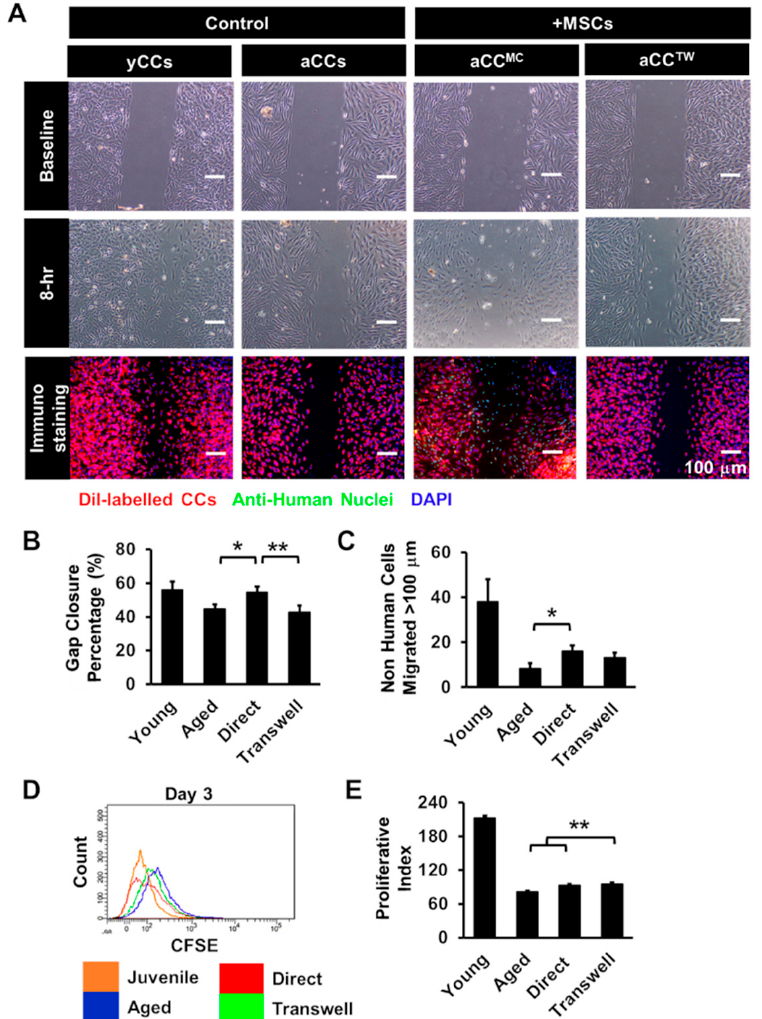
Figure 3. Co-culture with mesenchymal stem cells (MSCs) is capable of improving growth kinetics of aCCs. ( A ) Representative images of migrated cells after 8 h. CCs were labelled with DiI and MSCs were labelled with anti-human nuclei. Nuclei were stained in blue (DAPI). Scale bar = 100 µ m. ( B ) Histogram showed gap area repopulated by CCs following co-culture. ( C ) Number of CCs moved more than 100 µ m from the origin following co-culture. ( D , E ) Proliferative index of CFSE-labelled CCs following co-culture for three days. All data are mean ± SEM. * p < 0.05; ** p < 0.01. ( n =